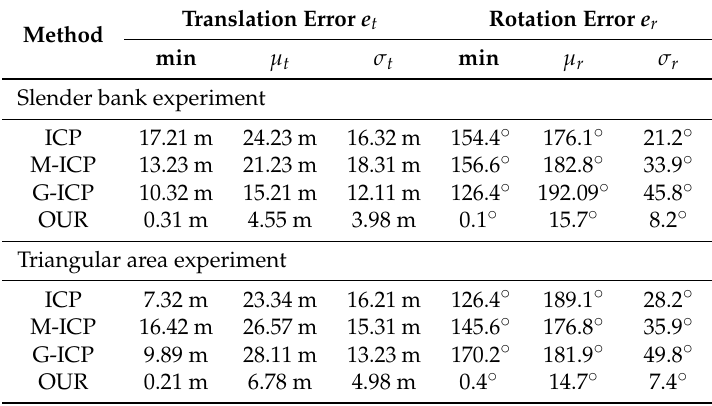
Table 3. Registration results with an abrupt